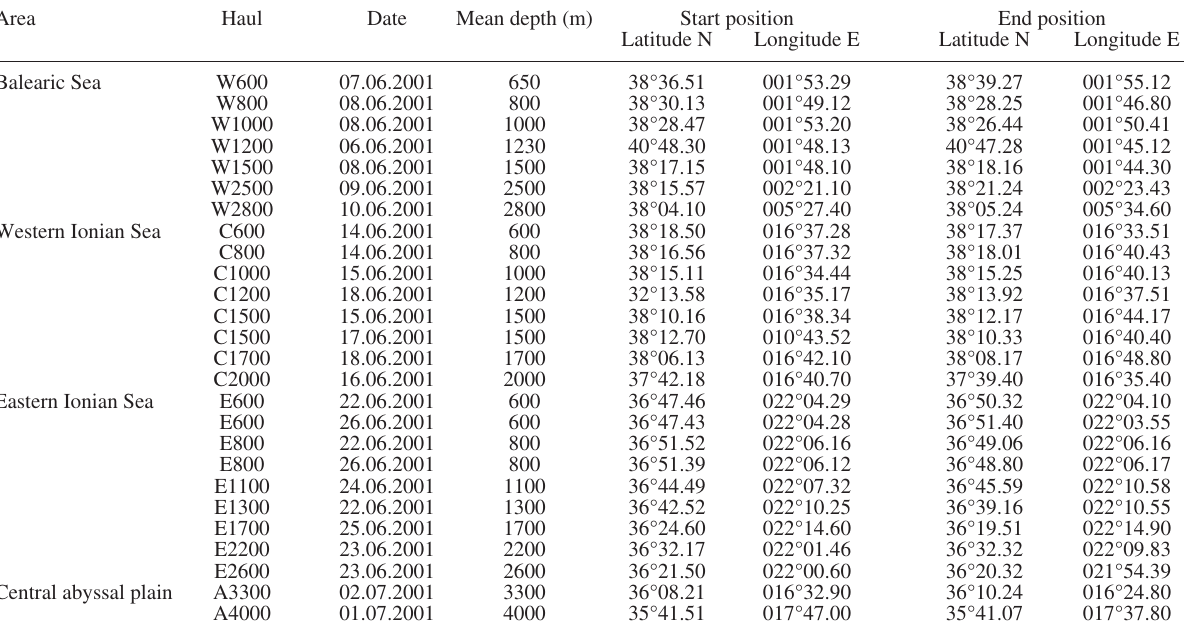
Table 1. – List of analyzed trawls with time and spatial characteristics.